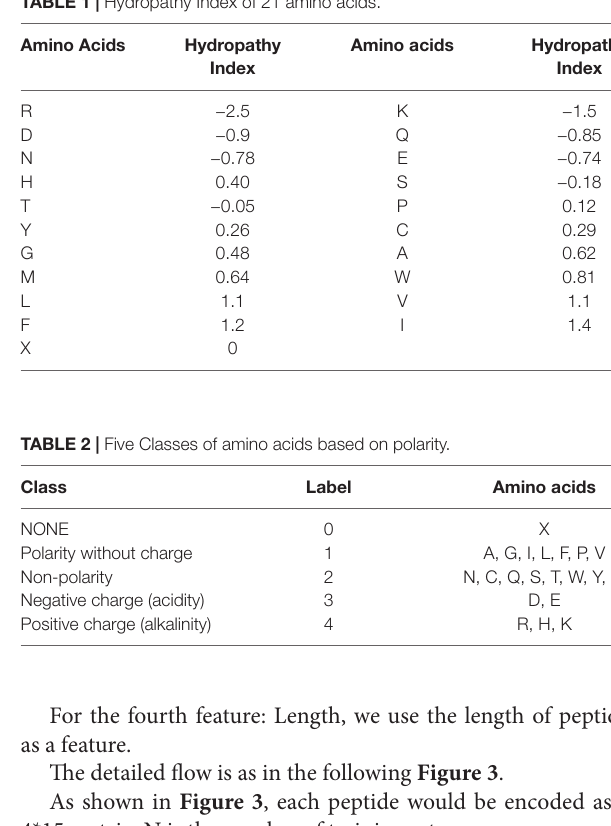
TaBLe 1 | Hydropathy Index of 21 amino acids.